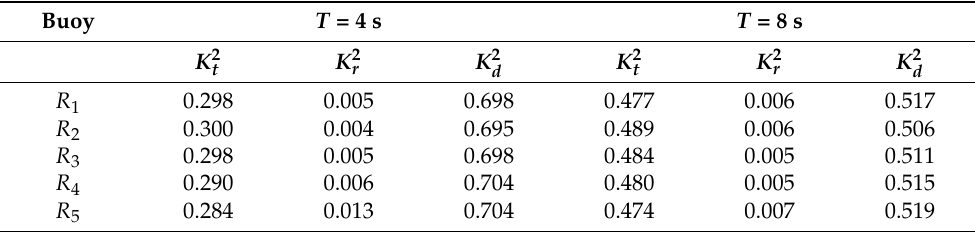
Table 6. Coefficients of energy transmitted ( K 2 different buoy sizes and during the two wave